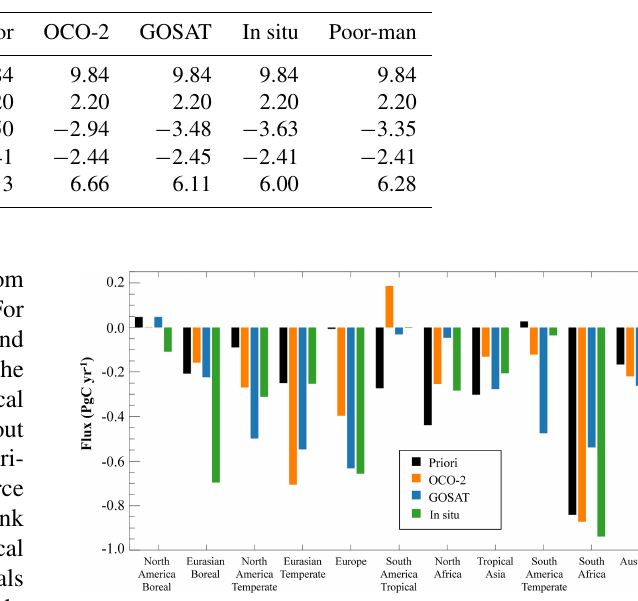
Table 2. Global carbon budgets estimated by the OCO-2 and GOSAT inversions in this study and those from the prior fluxes as well as in situ and poor-man inversions (PgCyr − 1 ) .